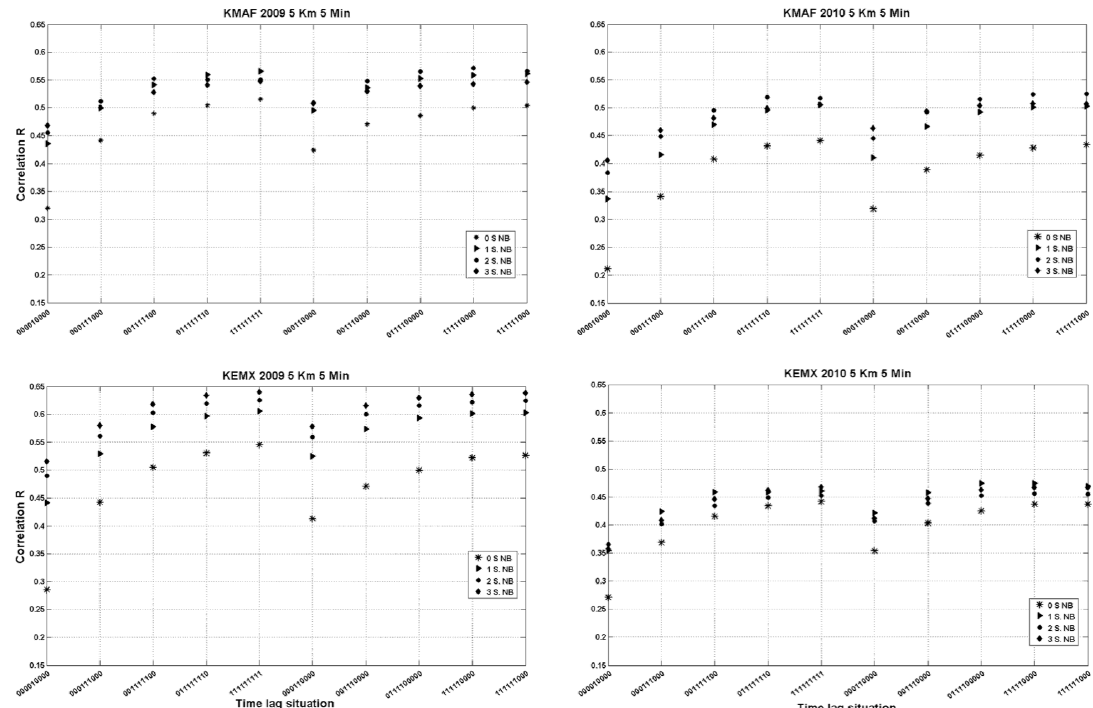
Figure 2. Space and time neighboring evaluation; top two panels, Southern Arizona region 2009 (left) and 2010 (right). Bottom panels, Midland, Texas region, 2009 (left) 2010 (right). The blue line represents zero SN, Green line 1 SN, red 2 SN and Blue 3